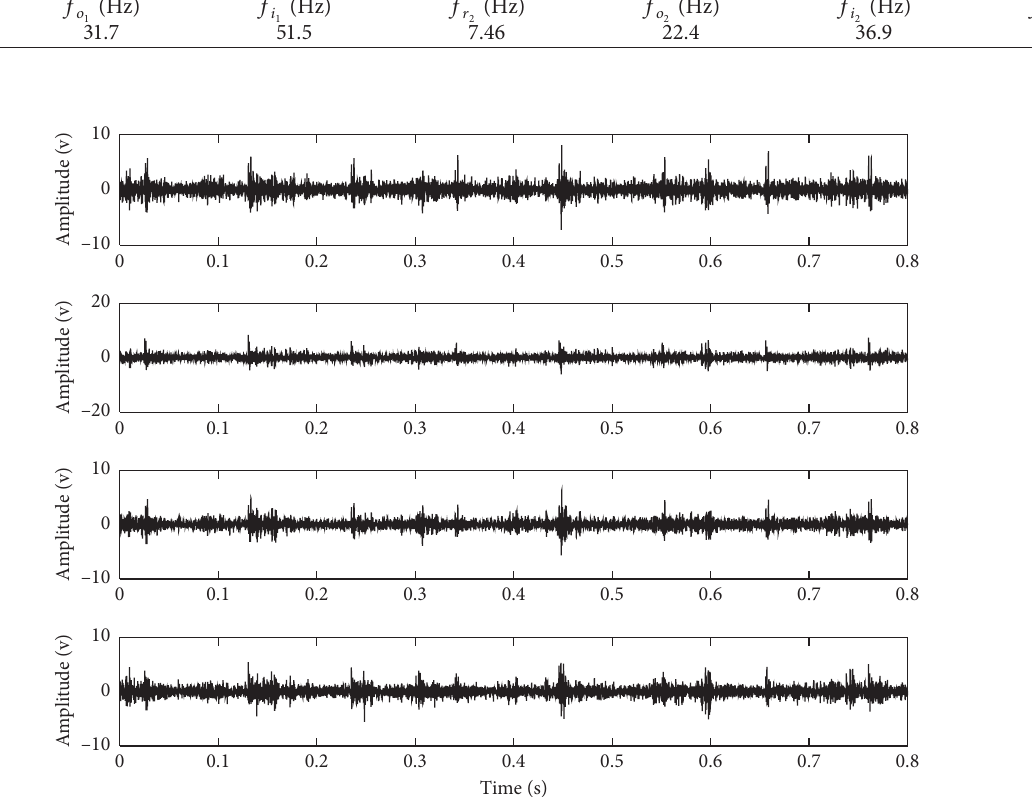
Figure 16: The 4 observed envelope demodulation spectral analysis would not work demodulation spectral analysis results are shown in effectively. In order to use this experiment to verify the Figure 17: the structures of the envelope demodulation effectiveness of the proposed method in underdetermined spectral lines as shown in Figure 17 are almost the same, blind source separation and conform to the subject of the and the inner race FCF and outer race FCF of the test paper, only the collected signals corresponding to mea- bearing could not be identified. The reason for the above suring points 2 and 3 are taken as the two observed signals, phenomenon is that the components of the four signals the reason for which is that the two signals are much are complex: gear meshing components, shaft rotating closer to the fault sources, and more fault characteristic component with its harmonics, and the rolling bearing components would be contained in them. Input the two fault signal components are all contained in them, so the